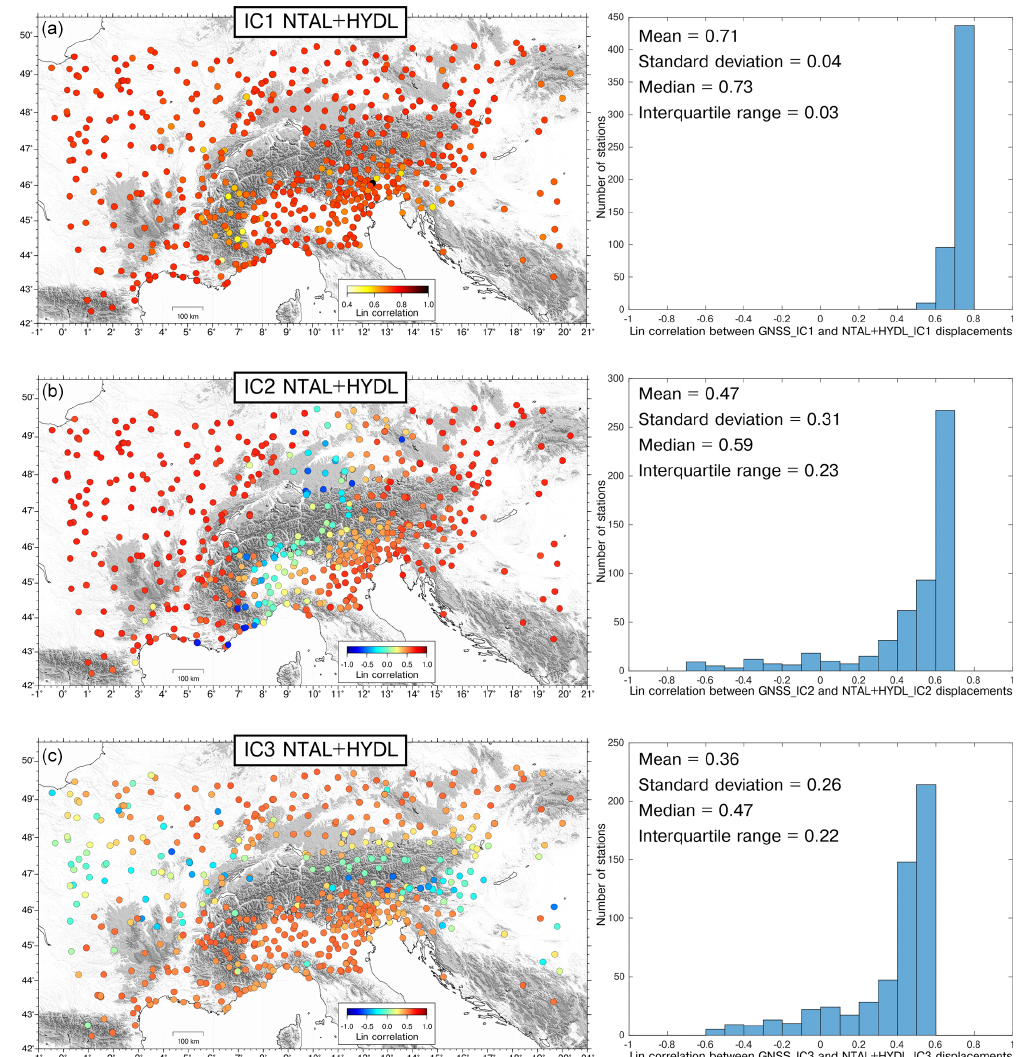
Figure 7. Lin correlation coefficients between (a) GNSS-IC1 and NTAL + HYDL_IC1, (b) GNSS_IC2 and NTAL + HYDL_IC2, and (c) GNSS-IC3 and NTAL + HYDL_IC3. Histograms of the correlation coefficients are also